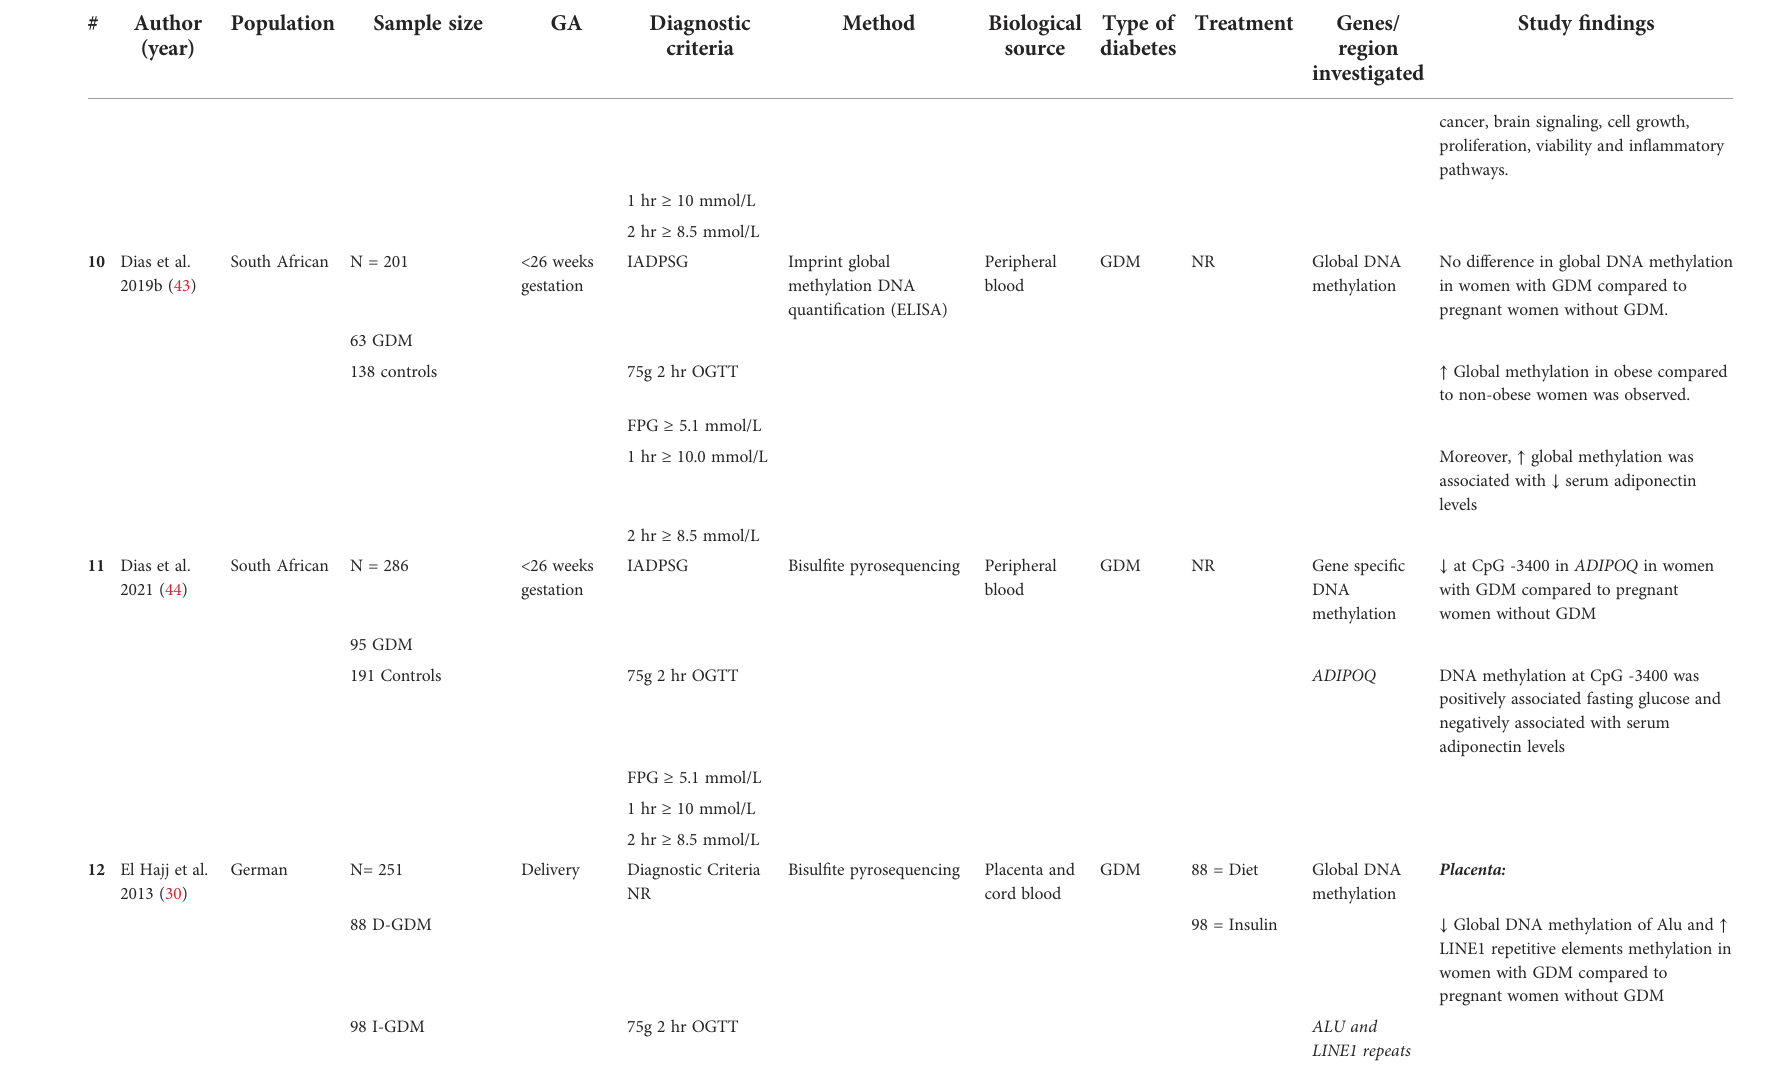
↓ Global DNA methylation of Alu and ↑ LINE1 repetitive elements methylation in women with GDM compared to pregnant women without GDM ALU and LINE1 repeats